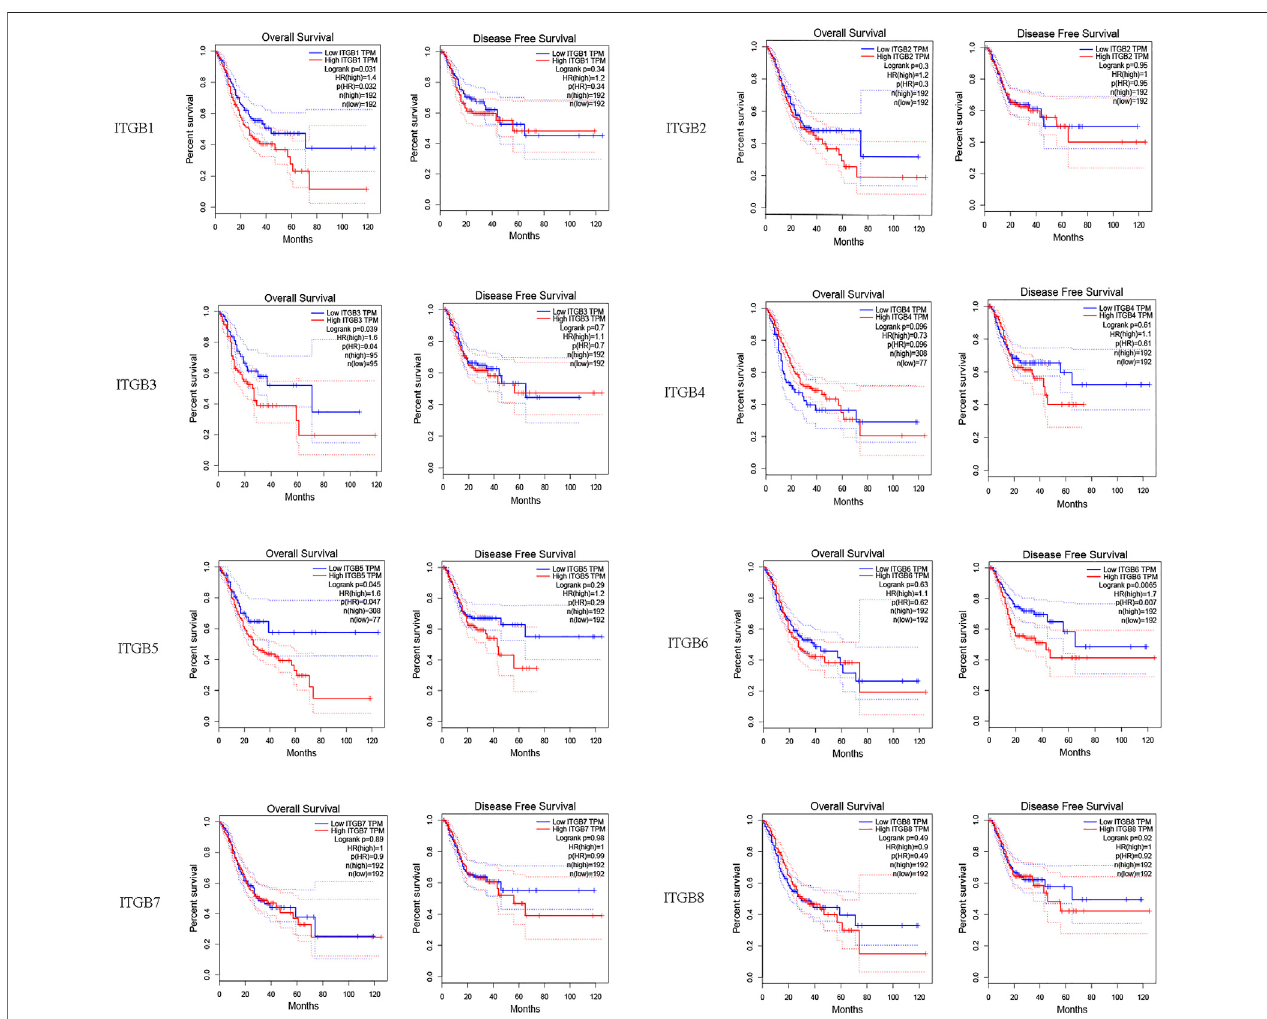
FIGURE 3 | Survival analysis and prognostic values of ITGBs in patients with GC (GEPIA).